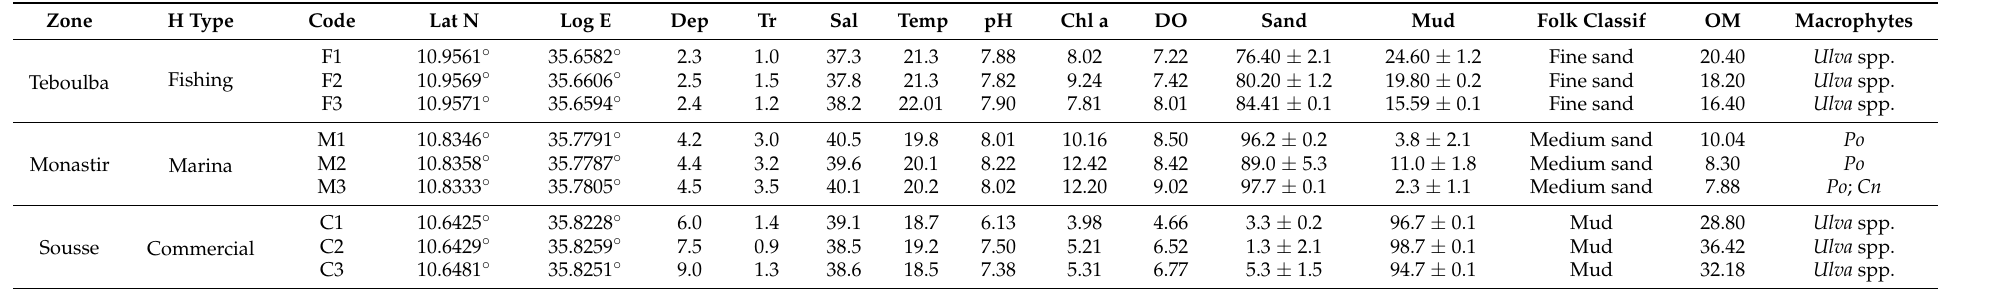
Table 1. Main characteristics of sampling stations and environmental factors measured during spring 2019. H. type: harbour type; Code: station code; Lat N: Latitude; Log E: Longitude; D: depth (m); Tr: transparency (m); Sal: salinity; Temp: surface temperature ( ◦ C); Chl a: chlorophyll ( µ g/g); DO: dissolved oxygen (mg.L − 1 ); OM: organic matter (%); Folk classif: Folk classification; Sand (63–2000 µ m); Mud (<63 µ m) (%); Po : Posidonia oceanica ; Cn : Cymodocea